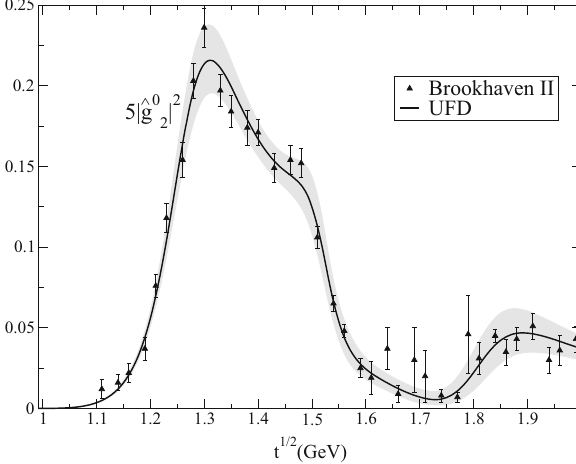
( t ) from the Brookhaven-II 2